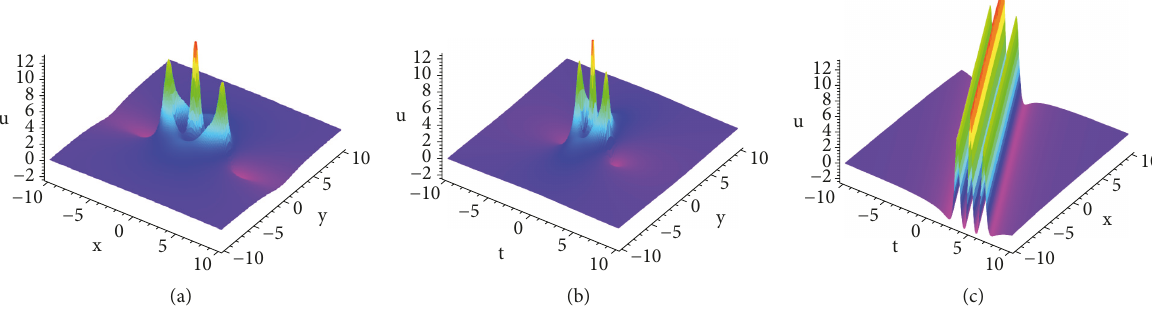
Figure 3: Plots (colored online) of rogue wave 𝑢 3 with 𝑚 = 2, 𝑎 = 𝑏 = −2 . (a) Perspective view of the wave 𝑢(𝑥, 𝑦,0) , (b) perspective view of the wave 𝑢(0, 𝑦, 𝑡) , and (c) perspective view of the wave 𝑢(𝑥, 0,𝑡) .